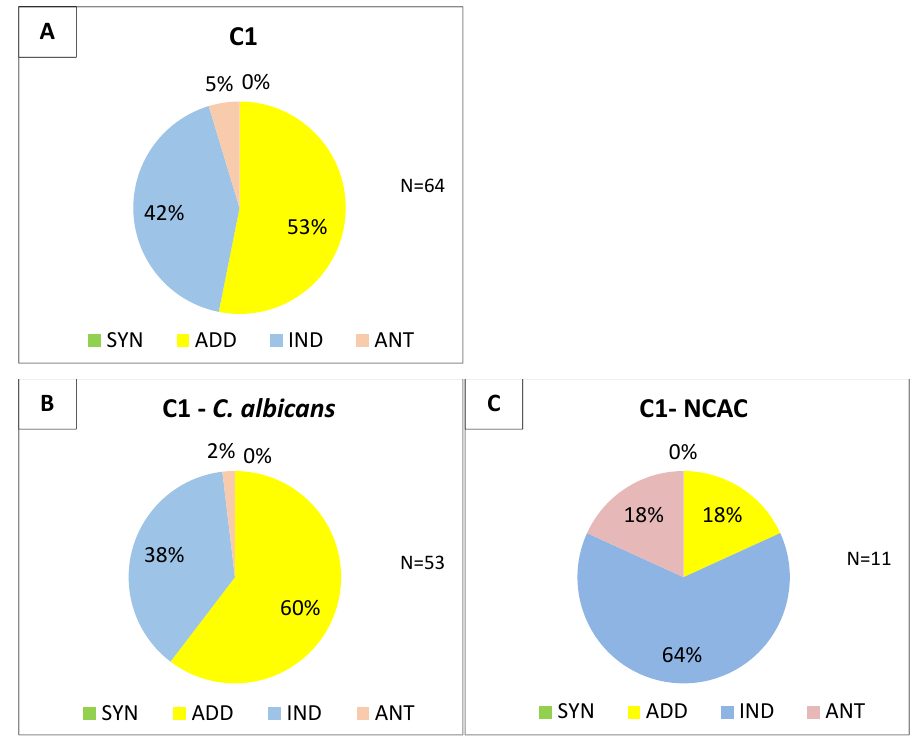
Figure 5. Distribution of FIC indices for the combination of fluconazole–C2; ( A ) total-64 strains; ( B ) C. albicans -53 strains; ( C ) NCAC-11 strains.